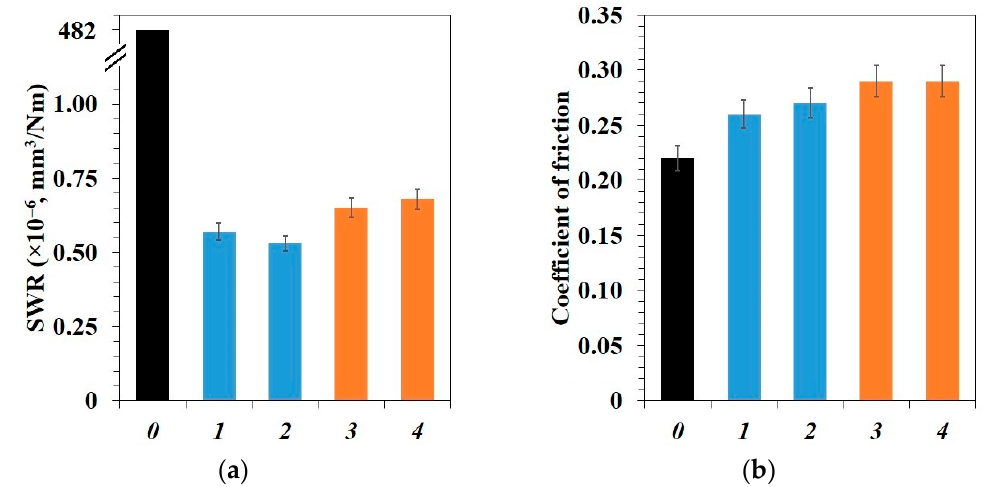
Figure 6. Tribological properties of PTFE and PCM: ( a ) specific wear rate; ( b ) coefficient of friction: 0 –initial PTFE; 1 –PTFE/CF/SiO 2 ; 2 –PTFE/CF/ZrO 2 ; 3 –PTFE/CF/SiO 2 /BN; 4 –PTFE/CF/ZrO 2 /BN.